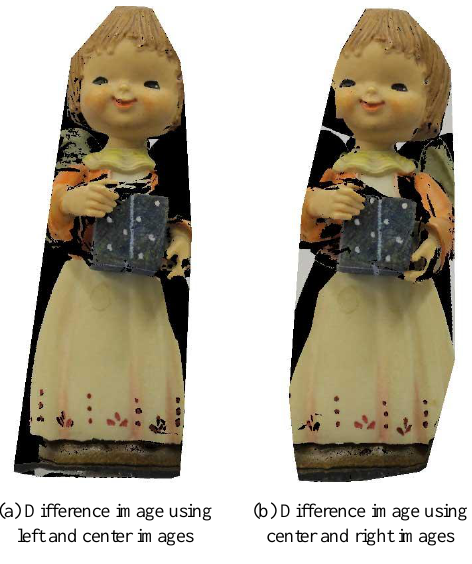
(a) Difference image using (b) Difference image using left and center images center and right Figure 9. Difference images.